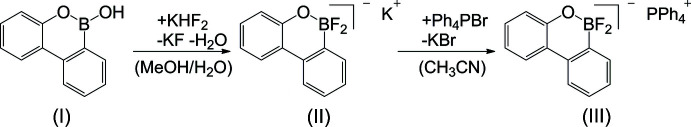
Synthesis of the 9,9-di­fluorido-10,9-oxabora­phenanthrene salts (II) and (III).